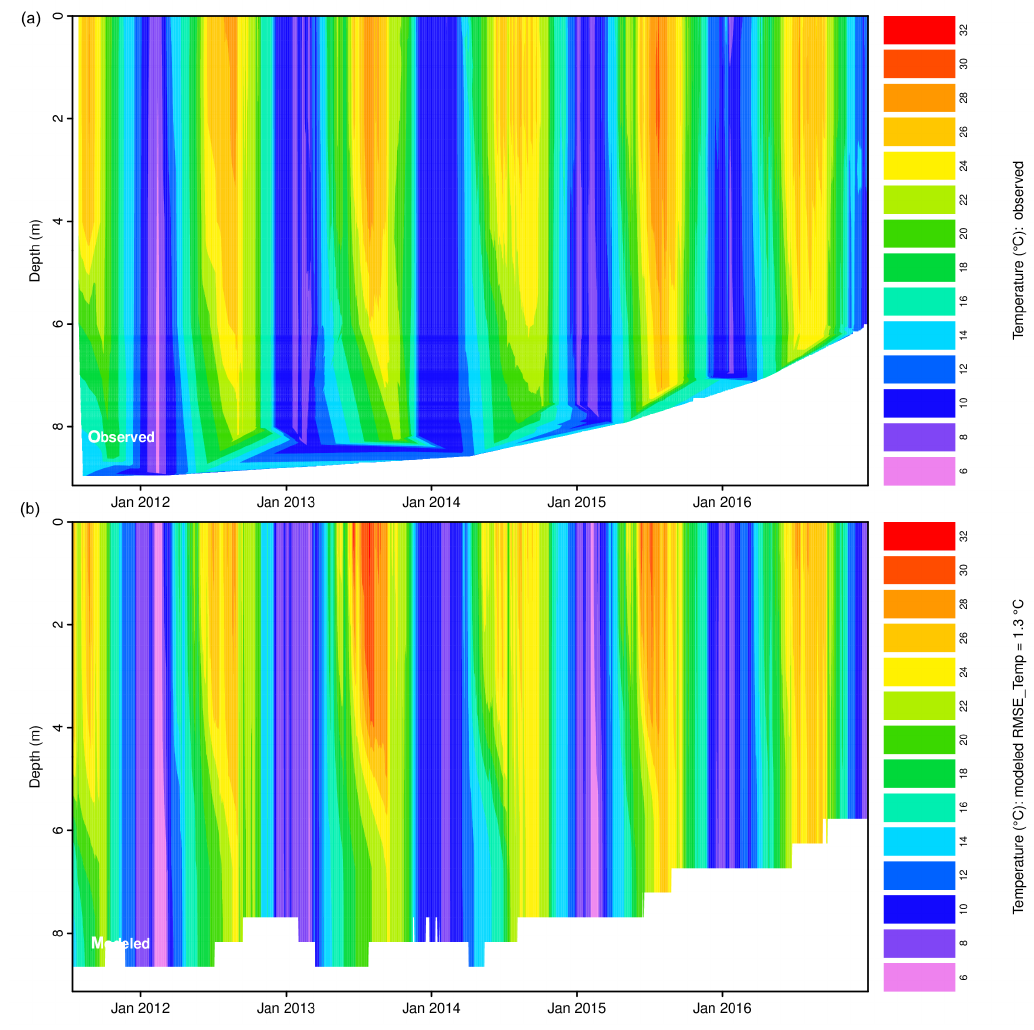
Figure 6. Observed (a) and simulated (b) water temperatures of lake